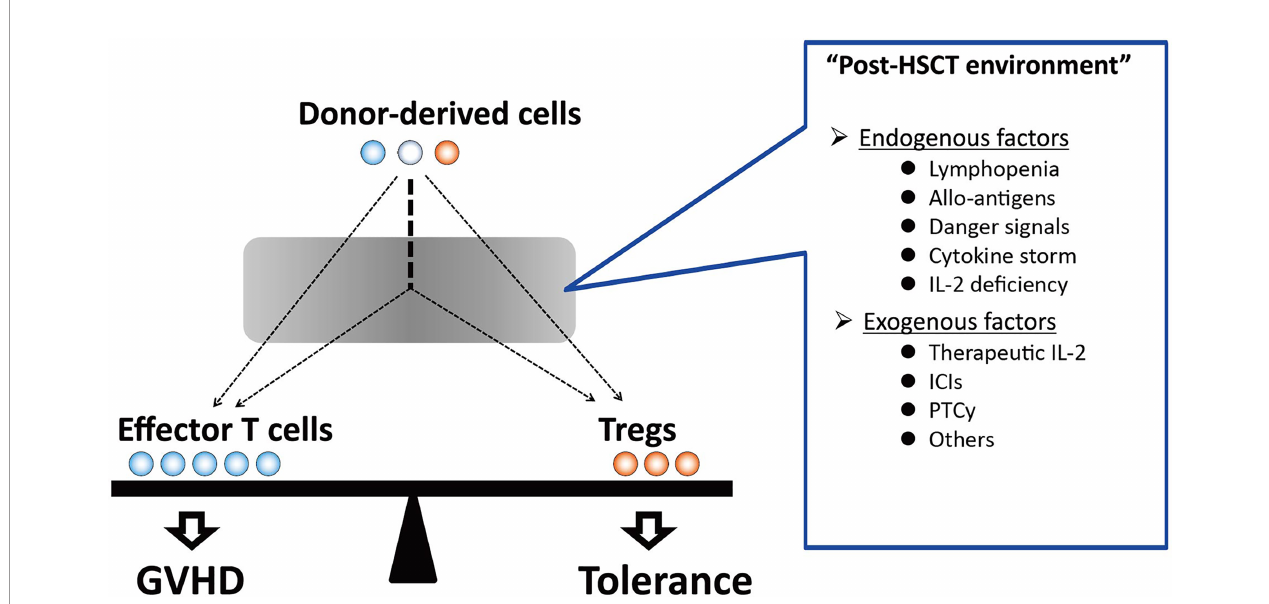
FIGURE 2 | The balance between effector T cells and Tregs in the distinct post-HSCT environment. After HSCT, donor-derived T cells are exposed to a variety of endogenous factors, including lymphopenia, alloantigens, danger signals, and cytokine storm, which affect the reconstitution of donor-derived immune cells. In addition, therapeutic interventions that have immunomodulating effects during the peri-transplant period also affect donor-derived T cell homeostasis. Unbalanced immune reconstitution may provide a basis for the pathogenesis of GVHD. In contrast, favorable Treg recovery in the post-transplant environment results in the induction of immune tolerance. GVHD, graft- versus -host disease; Treg, regulatory T cell; HSCT, hematopoietic stem cell transplantation; IL-2: interleukin 2, ICI, immune checkpoint inhibitor; PTCy, post-transplant